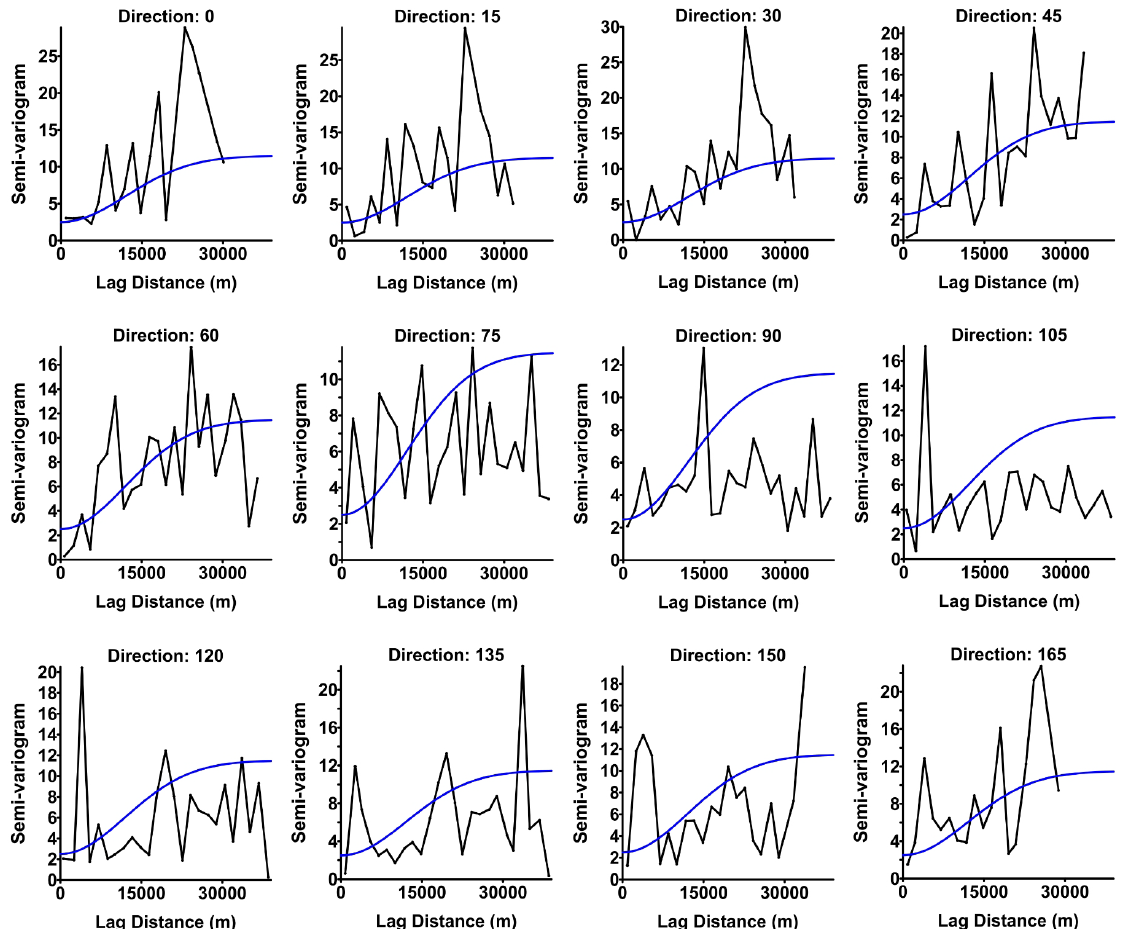
Figure 7. Directional variograms with 15° intervals and 15° angular